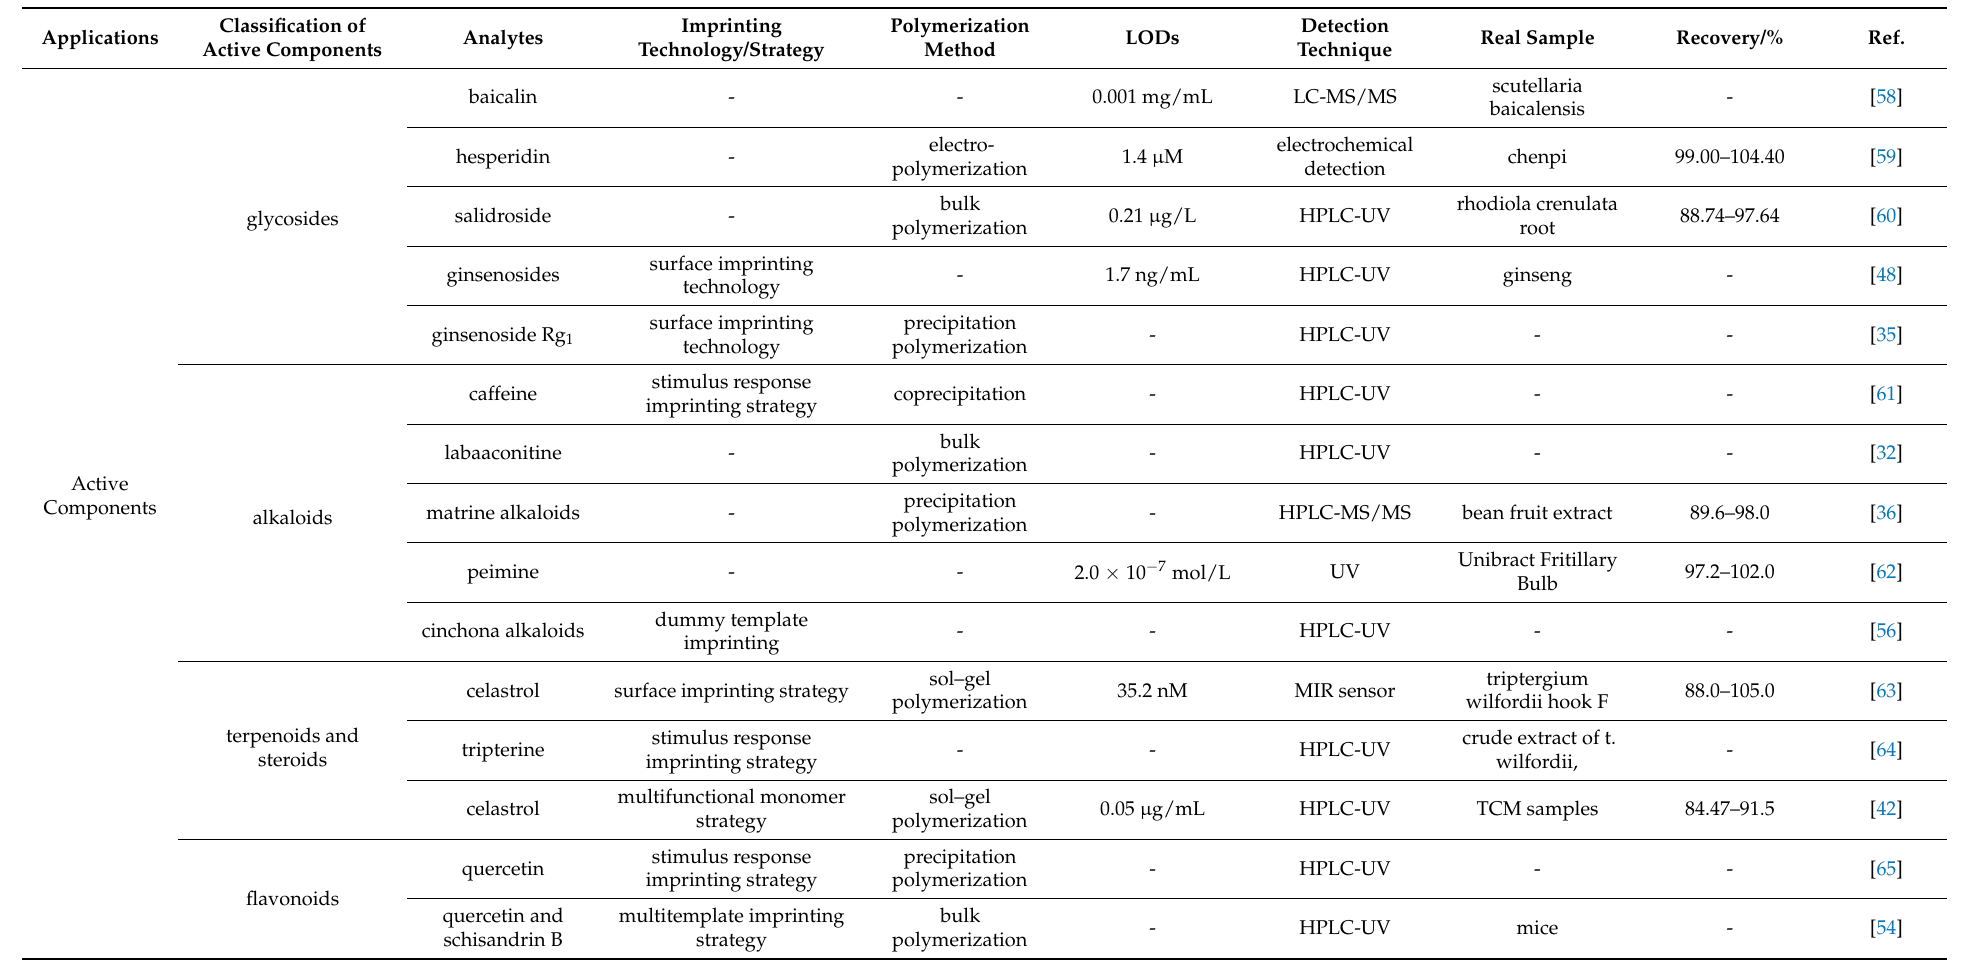
Table 2. Applications of MIT in